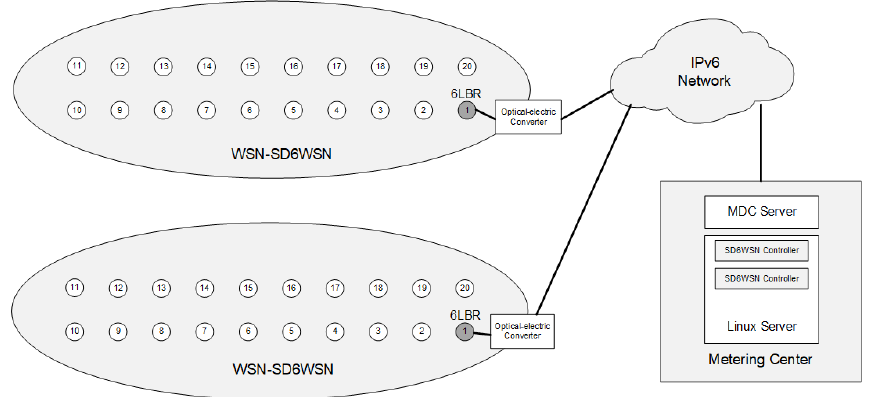
Figure 14. Advanced metering infrastructure (AMI) scenario. MDC, meter data